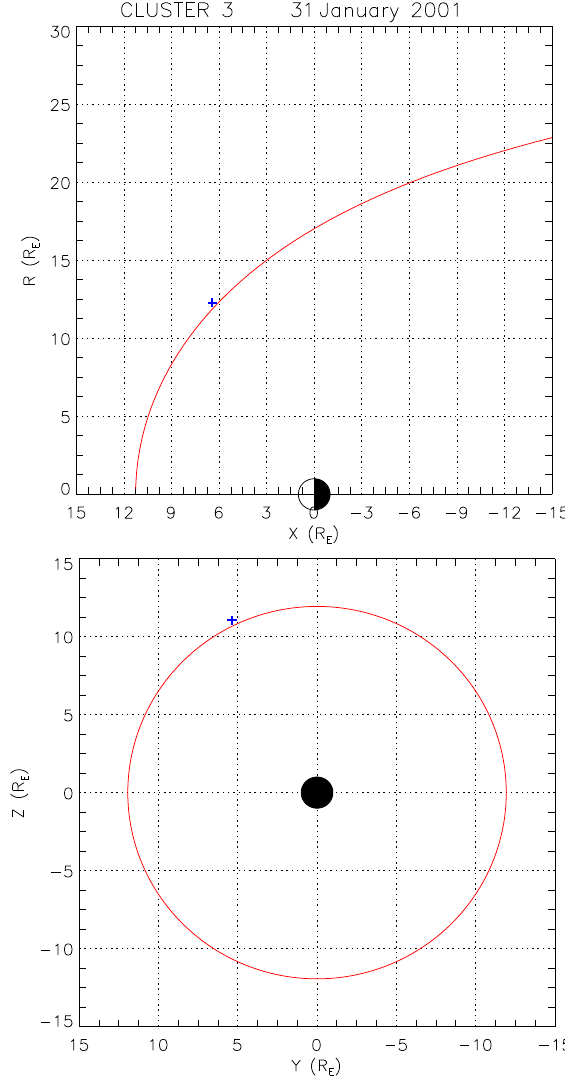
Fig. 1. Cluster location in a GSE coordinate system on 31 January 2001 around 05:45 UT. Top panel: projection in a X , R = (X 2 + Y 2 ) 1 / 2 frame. Bottom panel: projection in the ( Y , Z )